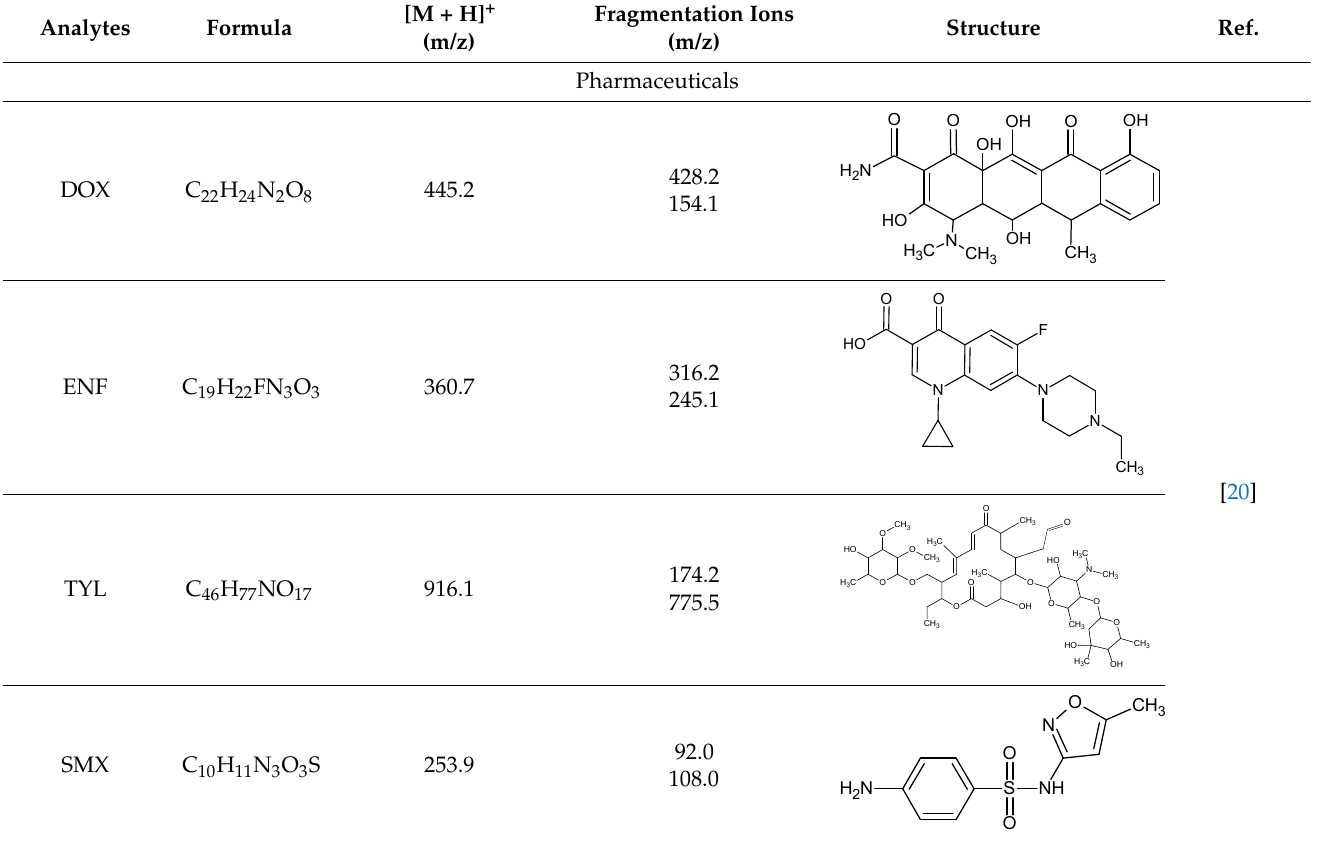
Table 3. Compilation of the determined pharmaceuticals and their identified transformation products. Analytes